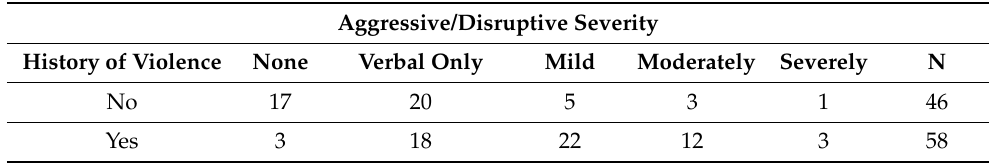
Table 4. The number of patients classified on Severity of Aggressive/Disruptive behaviors by medical history of violence based on UHDRS question 31.